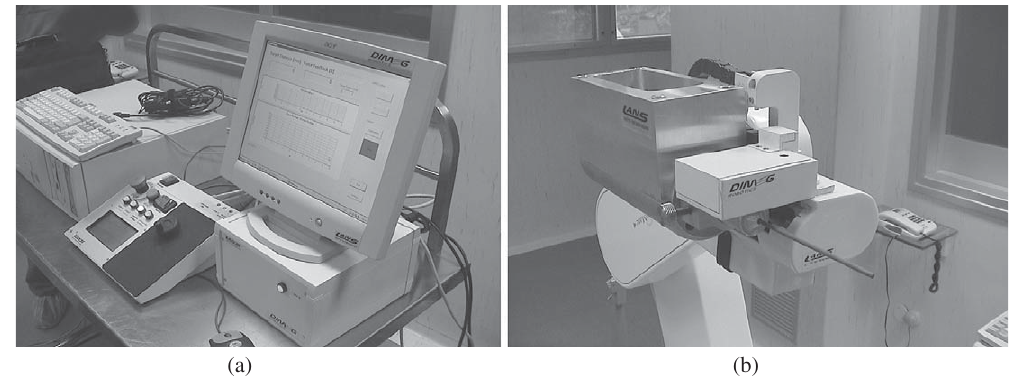
Fig. 4. Previous prototype: LANS (Linear Actuator for NeuroSurgery). a) Master module and LANS controller. b) Slave module and Neuromate arm at the Neurosurgical Department, University of Florence, Italy.